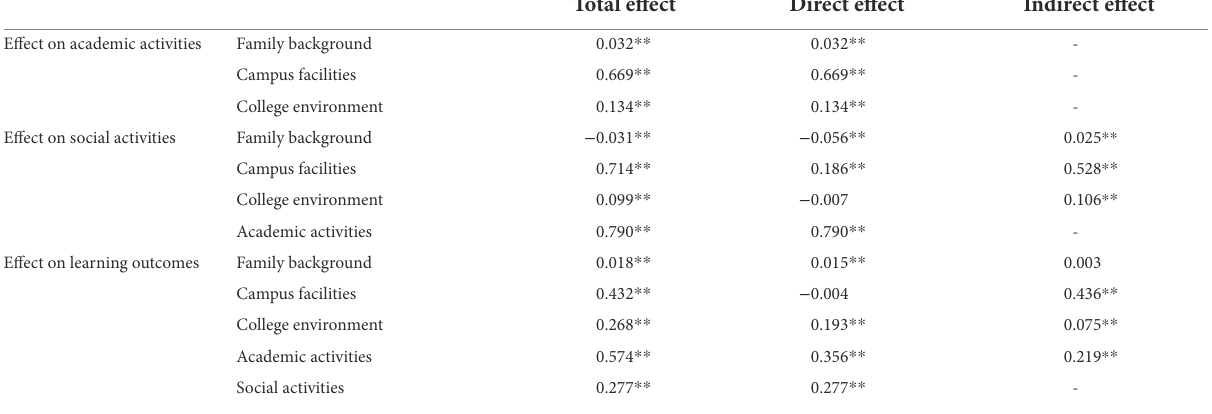
TABLE 2 The direct, indirect, and total effects on student learning